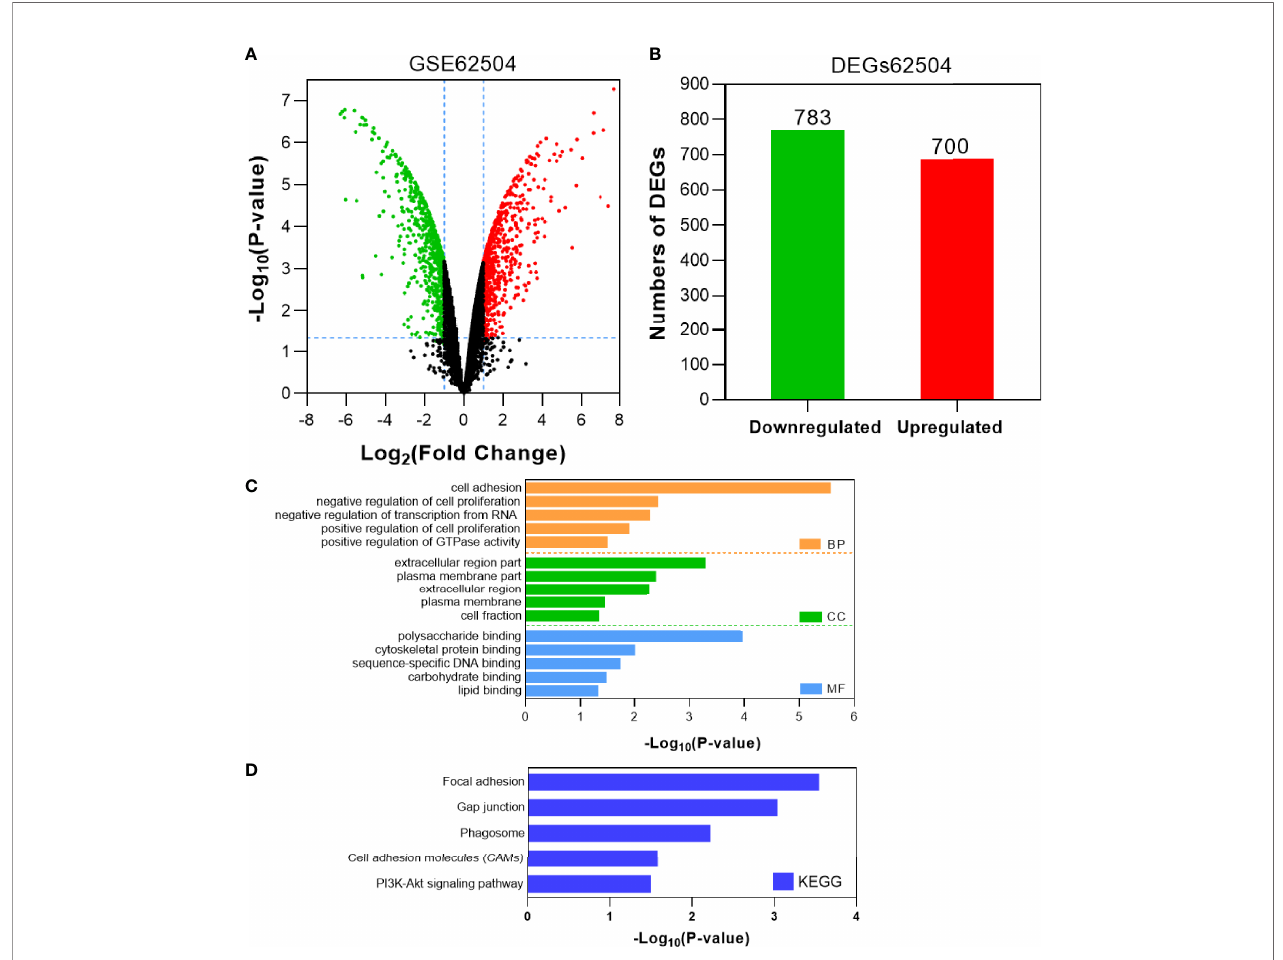
FIGURE 1 | Identi fi cation and characterization of DEGs from the GSE62504 dataset. (A) Volcano plot of DEGs between afatinib-resistant cells and parental cells. Red dots indicate signi fi cantly upregulated DEGs in afatinib-resistant cells; green dots, afatinib-resistant DEGs that were downregulated; black dots, no signi fi cant difference (P < 0.05 and |log2FC|>1.0 as the threshold). (B) Distribution of DEGs of signi fi cance in afatinib-resistant cells. The top fi ve GO terms (C) and KEGG enriched pathways (D) of signi fi cantly upregulated DEGs in NSCLC tissues are indicated. BP, biological process; CC, cell component; MF, molecular